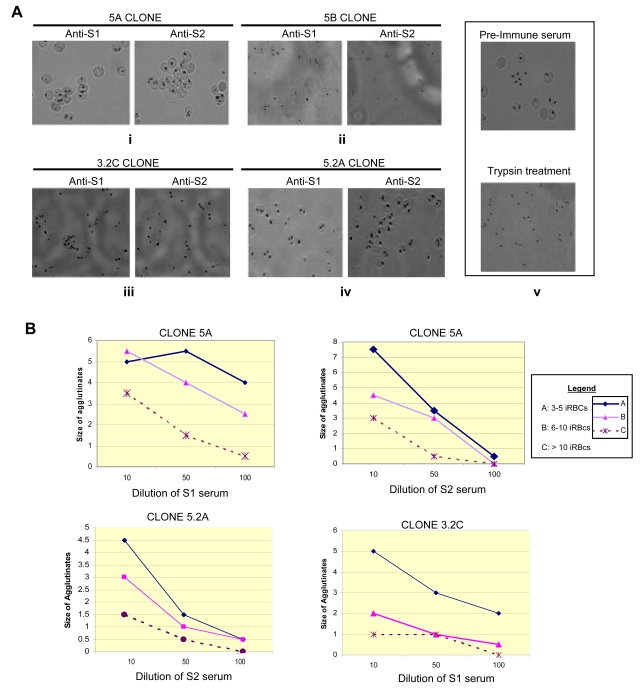
Parasites' phenotypes in agglutination assays.(A) Typical positive agglutinates of 5A-infected erythrocytes with anti-S1 and anti-S2 (panel i) sera and 3.2C (panel iii) and 5.2A (panel iv)–infected erythrocytes with anti-S1 and anti-S2 sera, respectively. Neither anti-S1 nor anti-S2 serum reacted with 5B (panel ii)–infected erythrocytes. Lack of reactivity was also observed with 5A-infected erythrocytes with pre-immune serum (panel v, upper square) and with anti-S1/S2 serum after trypsin treatment of the iRBC (panel v, lower square). (B) Proportion of iRBCs in parasites agglutinated by anti-S1 and/or anti-S2 sera. Size of the largest agglutinates decrease with increasing serum dilution. A, B, and C denote agglutinates with 3–5 iRBCs, 6–10 iRBCs, and >10 iRBCs, respectively.